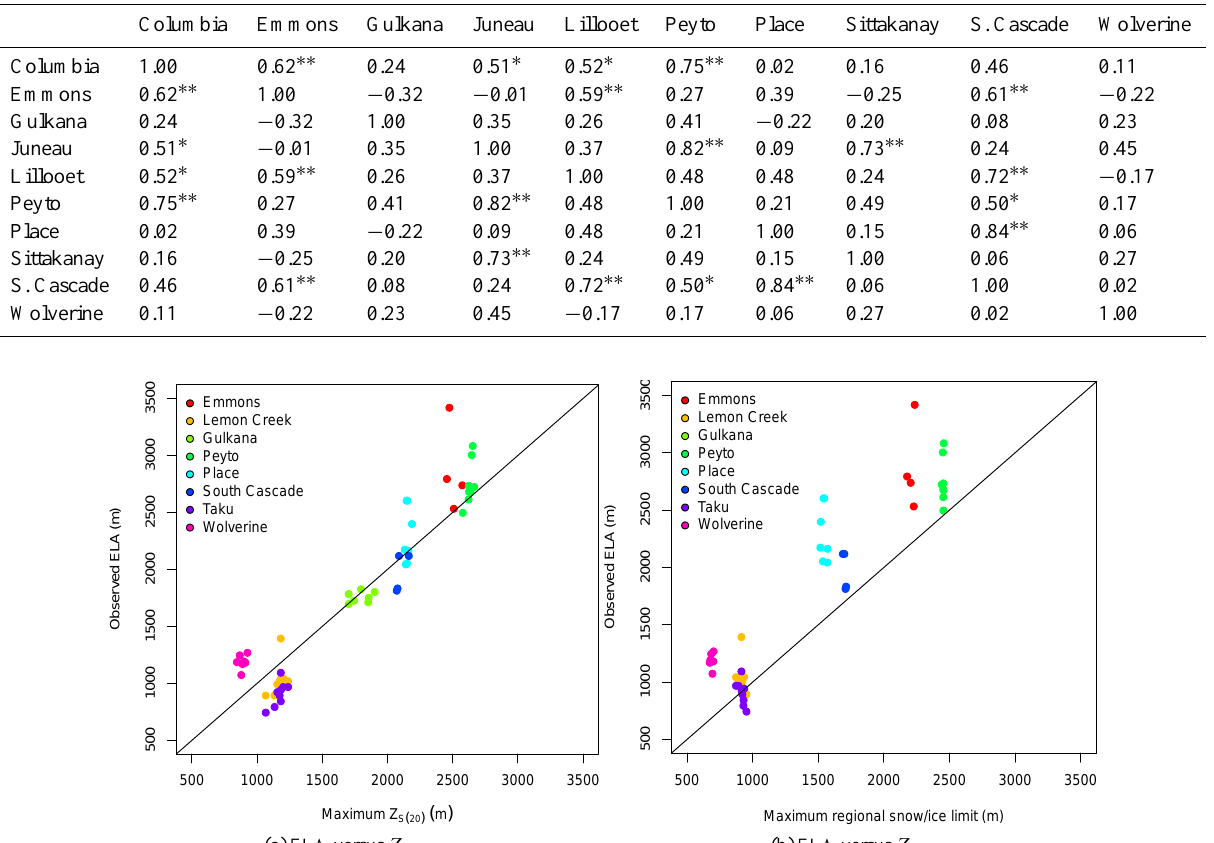
(b) ELA versus Z SL and S (20)